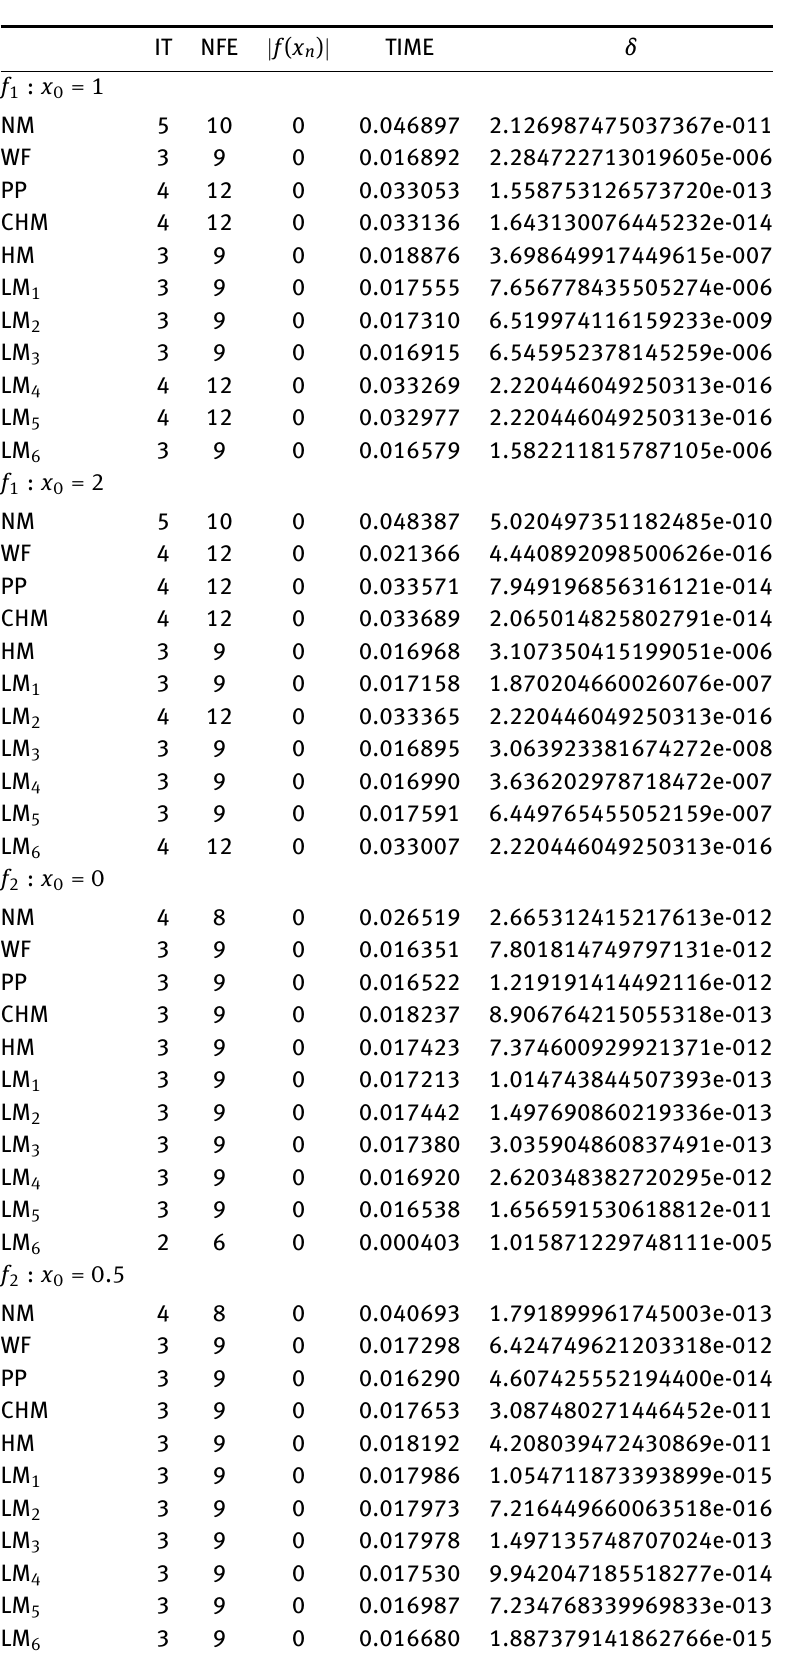
Table 2: Comparison of various third-order methods and Newton’s